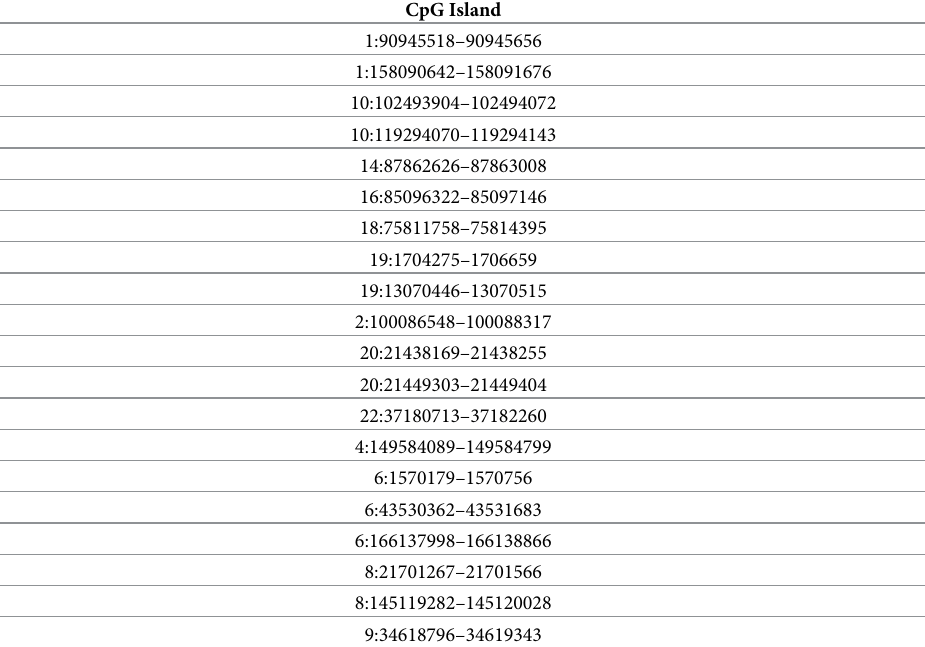
Table 1. CpG Islands in feature 120. List of CpG Islands agglomerated in F 120 , therefore assigned to the highest effect